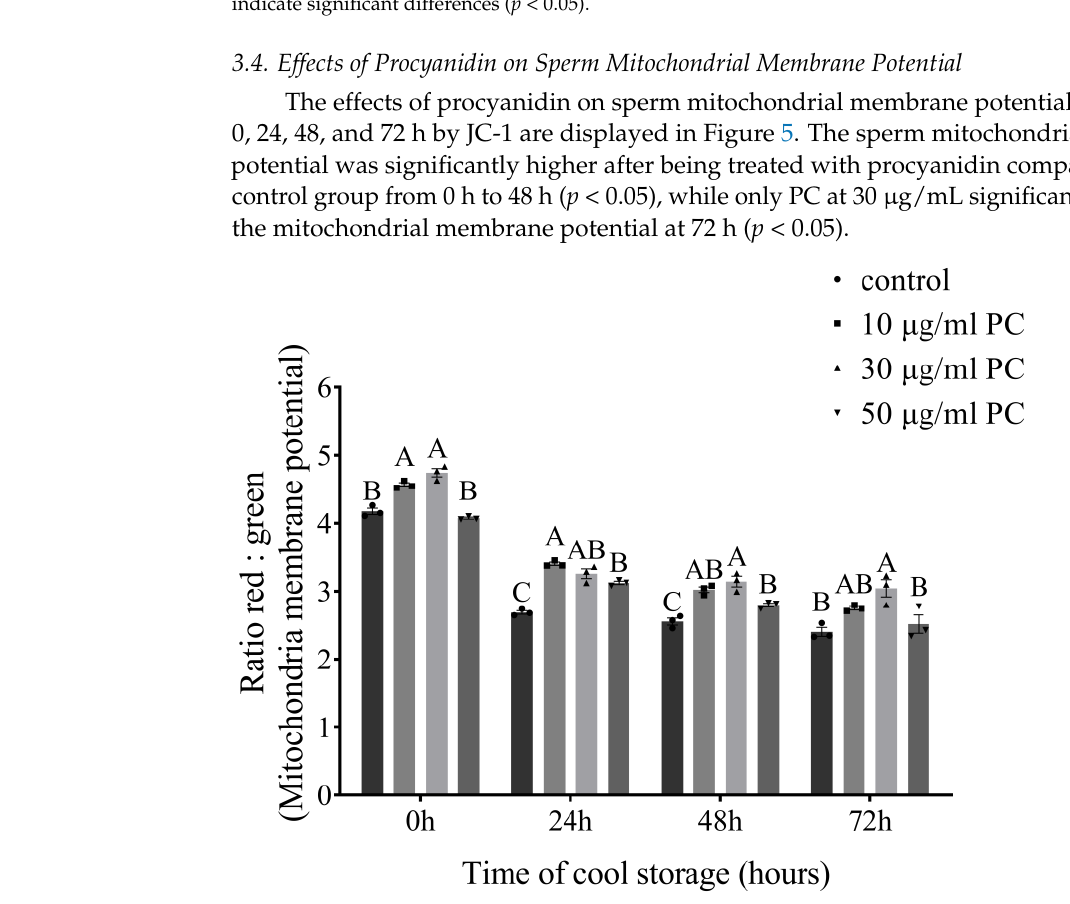
Figure 5. Effects of different concentrations of procyanidin on dog sperm mitochondrial membrane potential after being stored at a cool temperature for 72 h. Values are expressed as mean ± SEM ( n = 3). Different uppercase superscripts (A, B, and C) at the same time indicate significant differences ( p < 0.05).